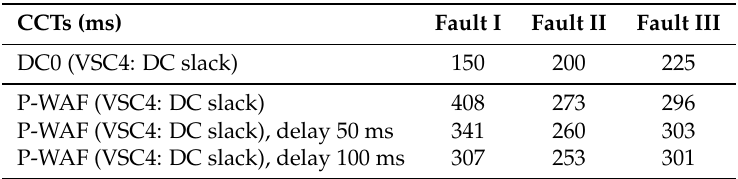
Table 8. CCT. Effect of communication latency on strategy P-WAF when the VSC-MTDC system has a single DC